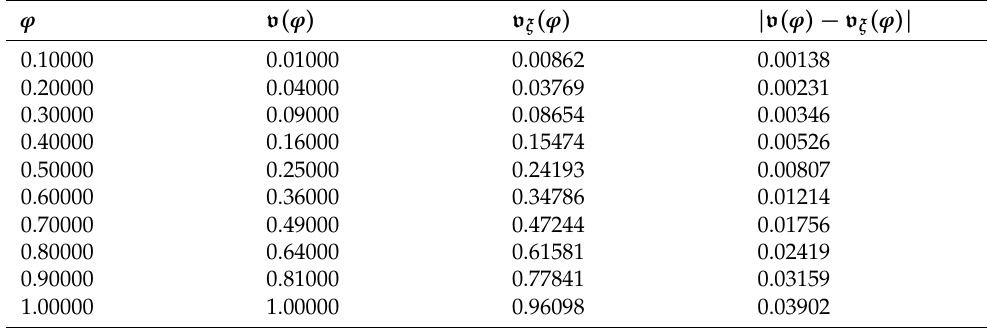
Table 1. The numerical and exact solution using the matrix approach method where ∼ = 51.